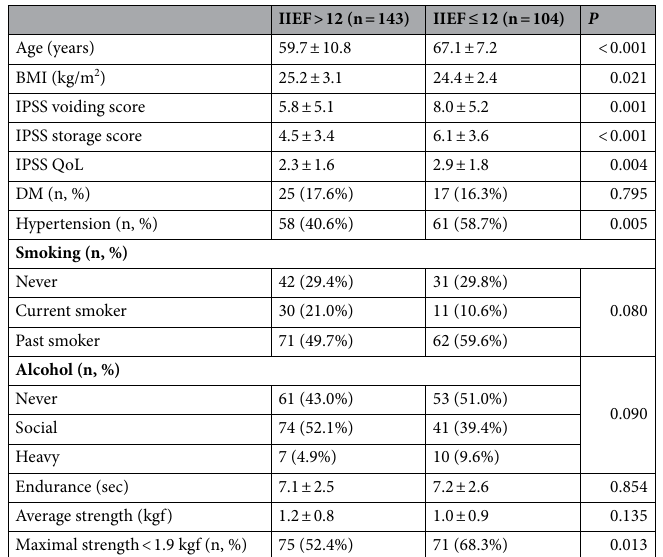
Table 1. Patient characteristics based on the International Index of Erectile Function-5 scores. BMI body mass index, IPSS international prostate symptom score, QoL quality of life, IIEF international index of erectile function, DM diabetes mellitus, kgf kilogram-force.